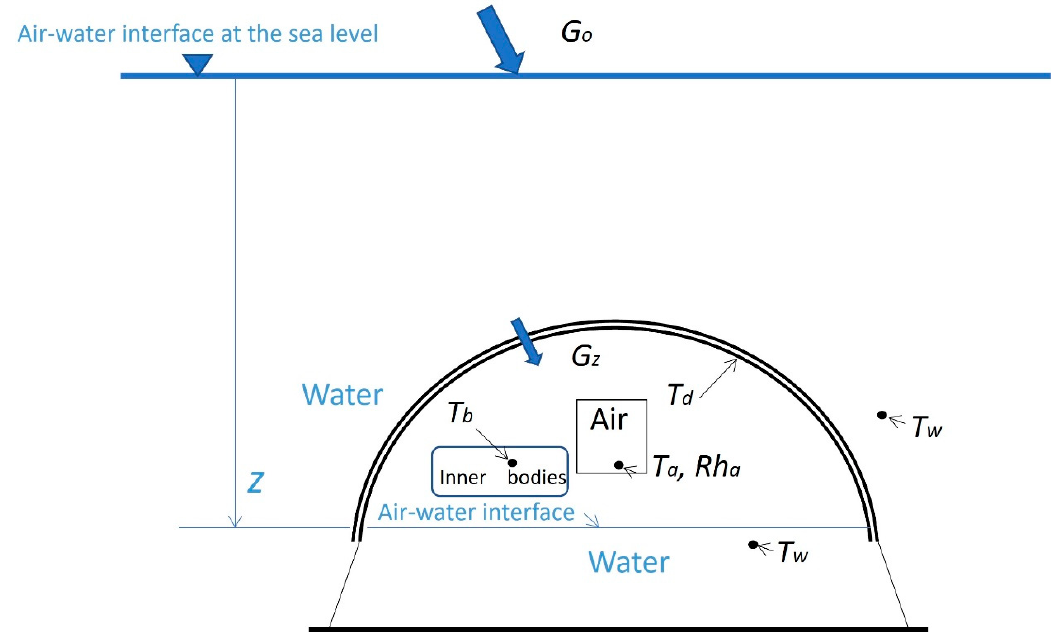
Figure 5. Schematic drawing of the biosphere and the variables included in the model.